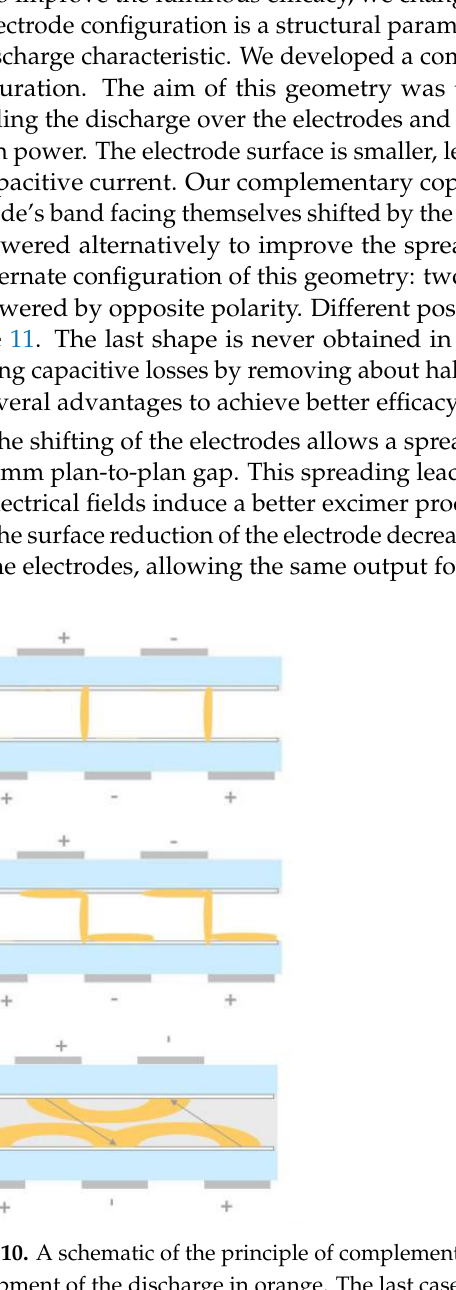
Figure 11. Pictures of the lamp with complementary coplanar electrodes for two voltages at 250 mbar and 20 kHz. 4 . Discussion Light emission with alternate complementary coplanar geometry is a succession of bright and dark lines. The optimal regime is not achieved as dark spaces are observed. In the bright zone, despite the impulse waveform, the regime is not homogeneous: filaments are observed with a fast ICCD camera. In Figure 11, two pictures are presented for high and low voltage (1500 V and 2400 V). The bright surfaces increase gradually with the volt- age. The discharge operates in a plane-to-plane state, but neither in a pure coplanar state. Discharges spread on the other side on the electrodes with opposite polarities. Visually, as the voltage increases, dark bands centered on the electrodes gradually narrow. Figure 12 shows a map of the luminance from a 250 mbar lamp in alternate comple- mentary configuration with pulse voltage. At 2200 V for 20 kHz, some irregularities are visible on the first and the third band due to filaments. Filaments could only be observed with an ICCD camera. The dark bands have a higher luminance than the outside of the lamp. The dark bands correspond to the region where the plasma does not completely spread. Increasing the voltage allows to spread more the plasma on the electrodes; the